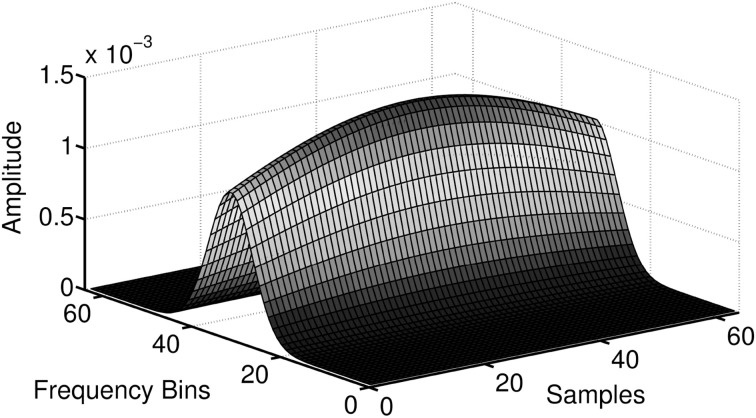
The implementation of the Gaussian smoothing kernel. Smoothing of the time-frequency distributions is necessary for CXY(t, f) to be well defined and produce meaningful results.